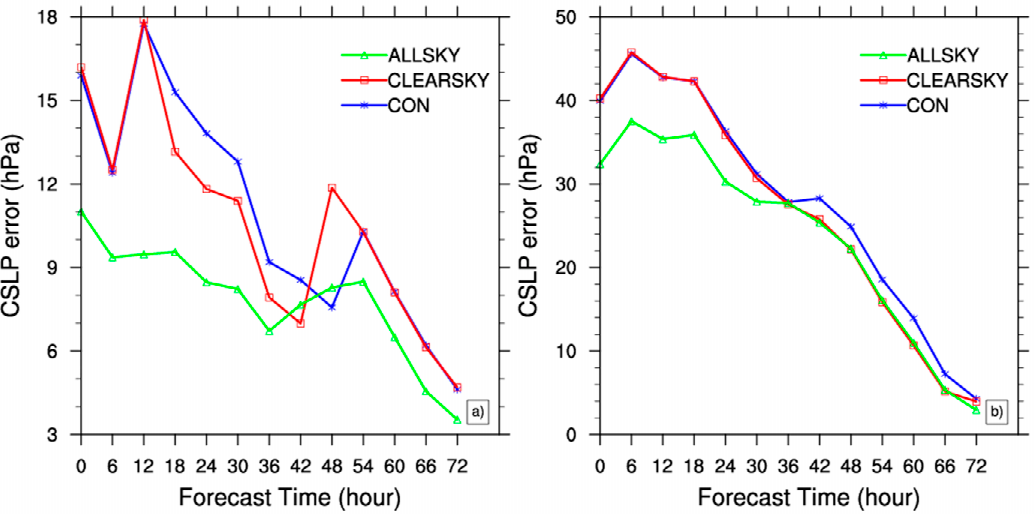
Figure 6. The averaged absolute central sea level pressure (CSLP) errors against JTWC best tracks from the three experiments for ( a ) Chan-hom and ( b ) Nangka.